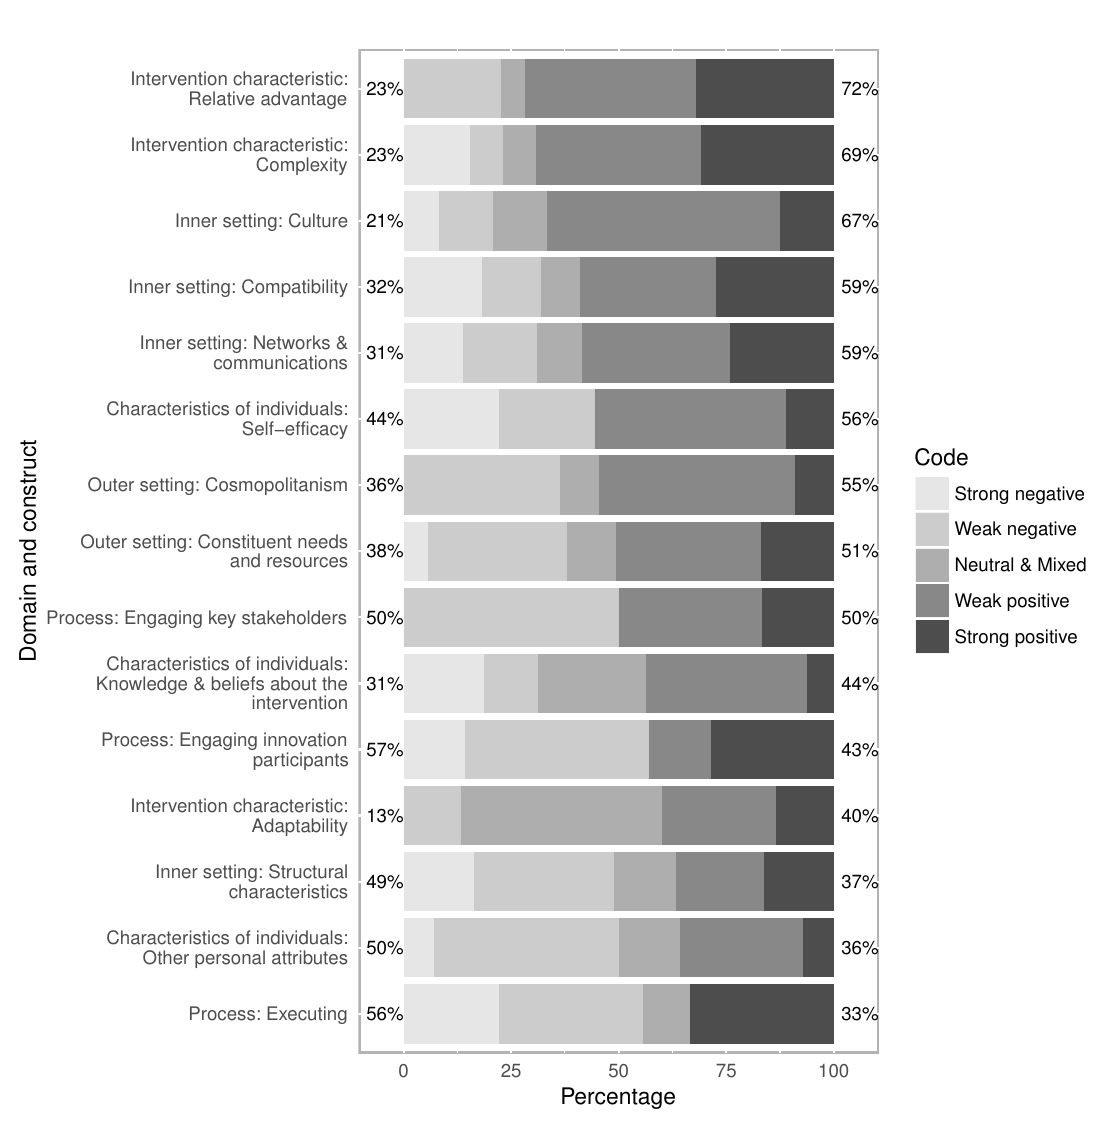
Figure 2. Percentage of ratings for all constructs with more than five mentions across all